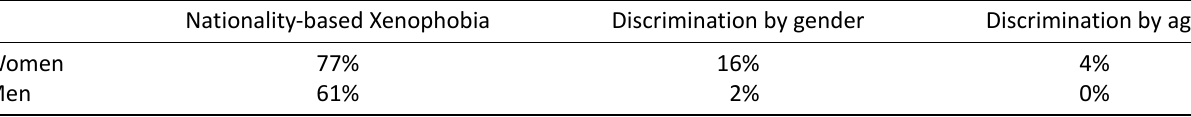
Table 1. Type of discrimination experienced by gender (quantitative data).